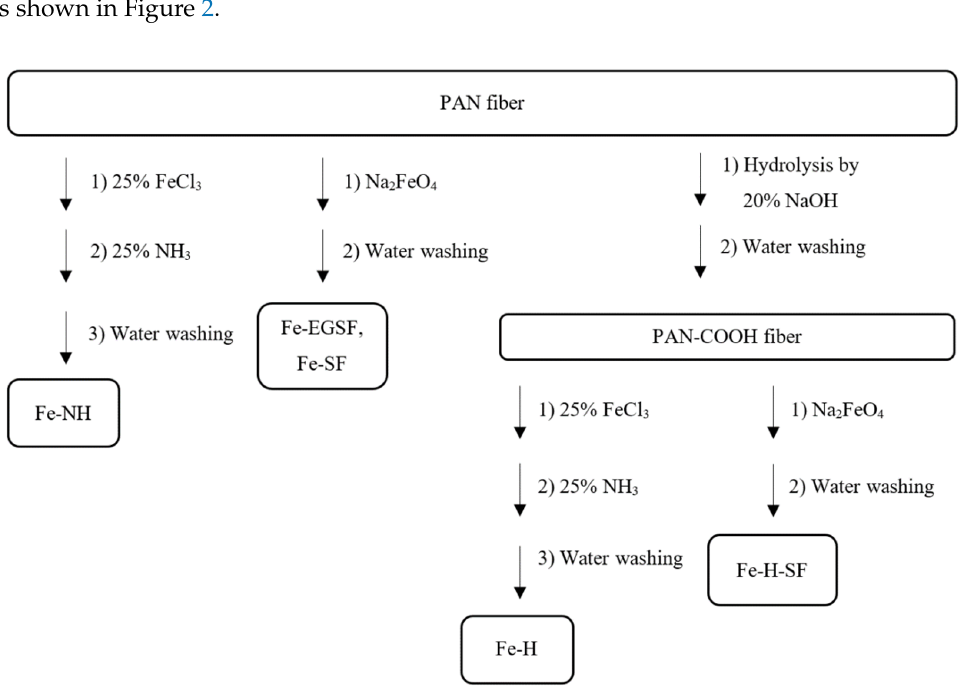
Figure 2. Scheme for obtaining sorbents based on PAN and Fe(OH) 3 using various